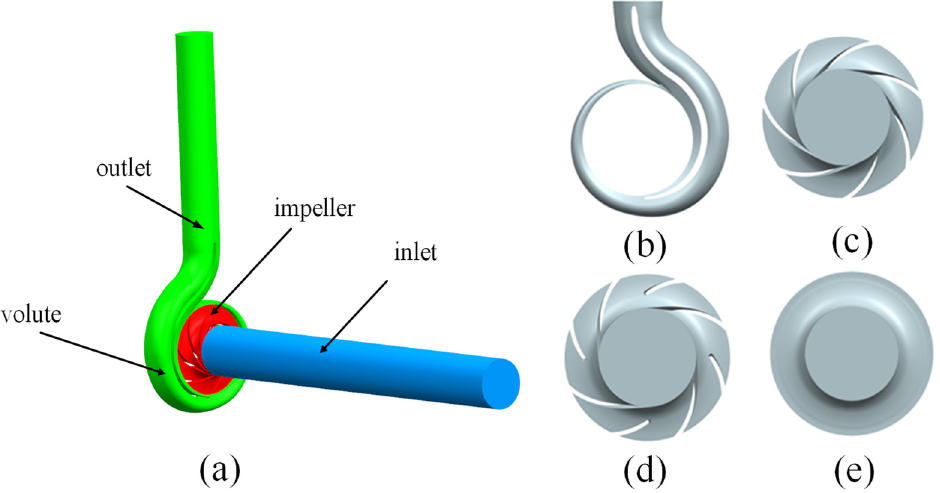
Figure 1. Fluid domain and 3D model of the centrifugal pump parts: ( a ) Fluid domains, ( b ) Volute, ( c ) Closed, semi-open impeller, ( d ) Split blade impellers, ( e ) Pump bonnet.